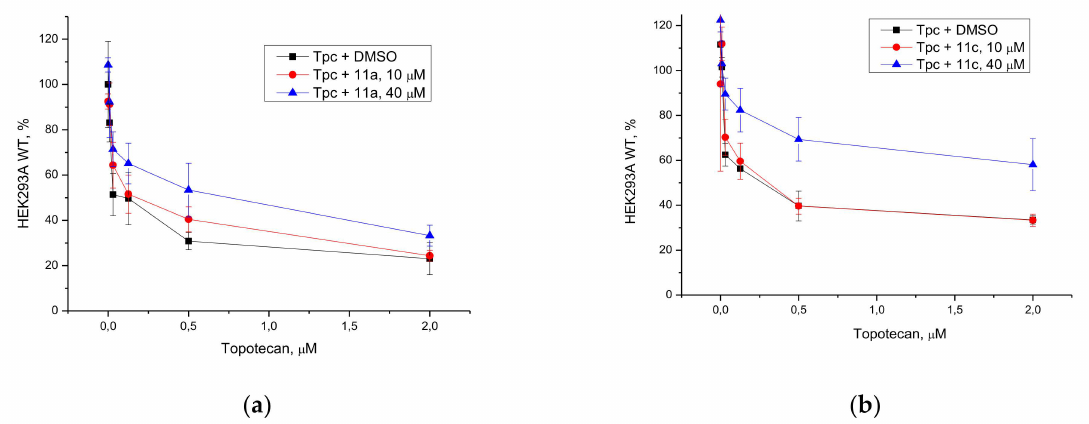
Figure 8. Topotecan (Tpc) cytotoxicity on HEK293A WT cells—dose-dependent action of Tpc in combination with 11a ( a ) or 11c ( b ).